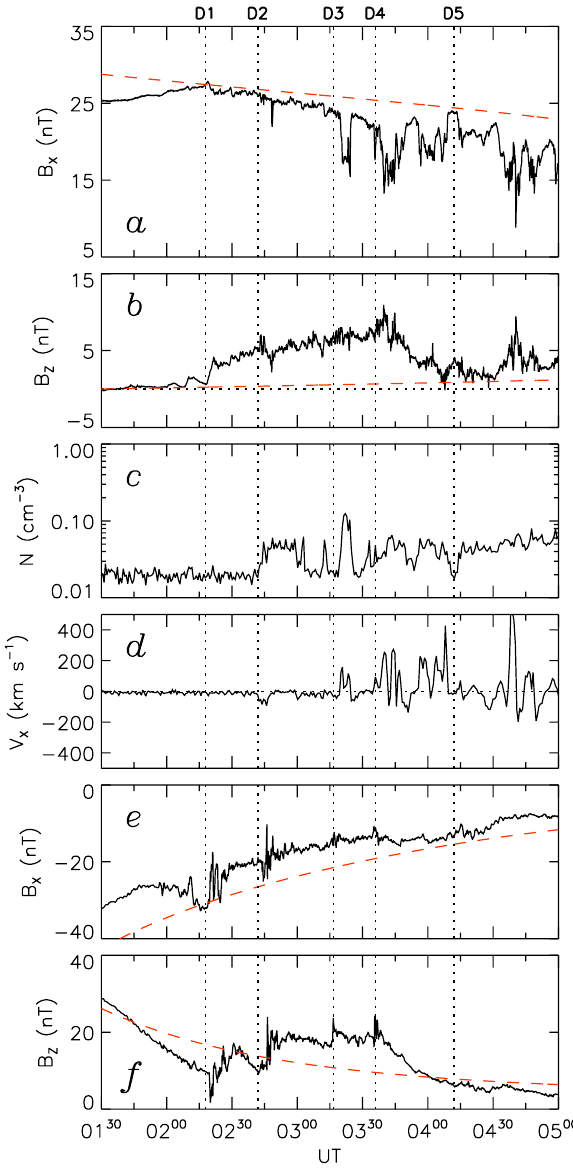
Fig. 3. Cluster-1 and Double Star TC1 observations from 01:30- 05:00 UT, 29 August 2004. (a) and (b) B x and B z components of the magnetic field from C1. (c) and (d) Ion density and V x ion velocity from C1. (e) and (f) B x and B z components of the magnetic field from